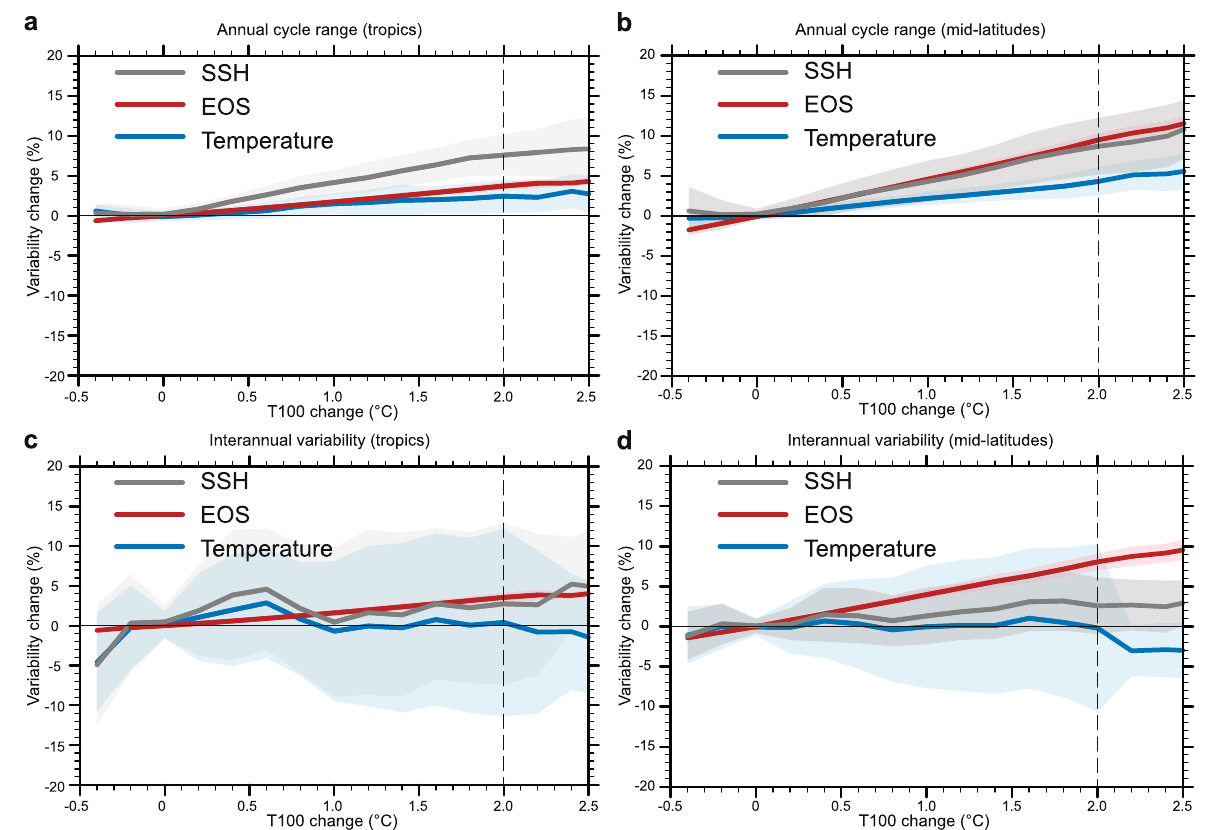
Fig. 6 CMIP5 projected changes of the SSH, EOS, and temperature variability with respect to the projected warming in T100 (°C). a , b Annual cycle range for the tropics and mid-latitudes, respectively. c , d Same but for interannual variability. Changes are calculated over 30-year running windows, started every 5 years from 1906 – 2100, relative to the 30-year climatology at the end of the historical experiment (1976 – 2005). Solid lines indicate the multi-model averages for each 0.2 °C bin of temperature change. The shadings indicate uncertainty (±1 standard deviation) across the models. For 2 °C warming (vertical lines), which occurs in 26 out of 29 models by 2100 in the tropics, the annual cycle changes ( a ) are 8% (SSH), 4% (EOS), and 2% (temperature). The respective changes in the mid-latitudes (21 models; b ) are 9% (SSH), 10% (EOS), and 4% (temperature). The interannual variability changes for 2 °C warming are, for the tropics ( c ), 3% (SSH), 4% (EOS), and 0% (temperature) and, for the mid-latitudes ( d ), 3% (SSH), 8% (EOS), and 0% (temperature).